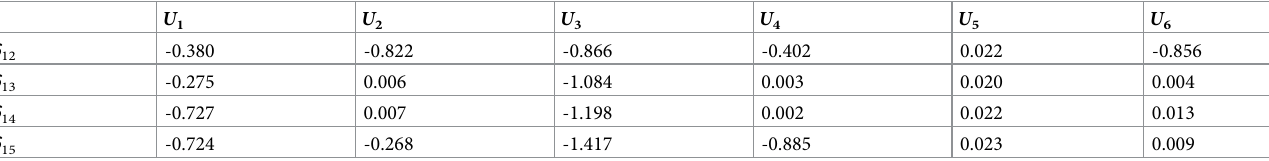
Table 19. The relative dominance of O 1 to others.